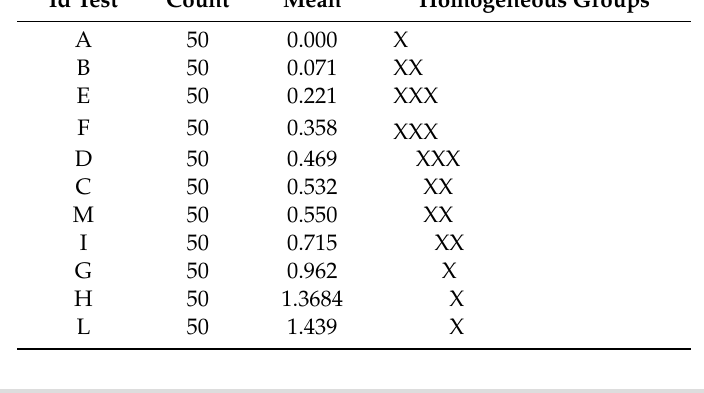
Table 4. Multiple Range Tests: Tukey’s HSD test at 95.0% confidence level. Table 3. Results of the Analysis of Variance.